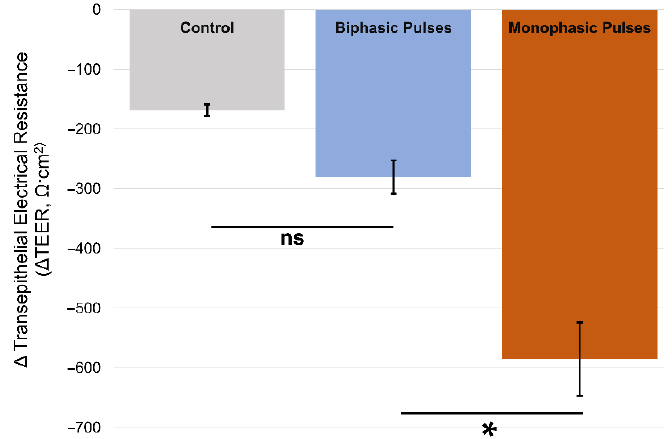
Figure 4. TEER measurement results. Samples exposed to monophasic electric field pulses demonstrate statistically relevant changes in TEER measurements. Here, ns indicates results which are not statistically significant, while * indicates statistical significance.